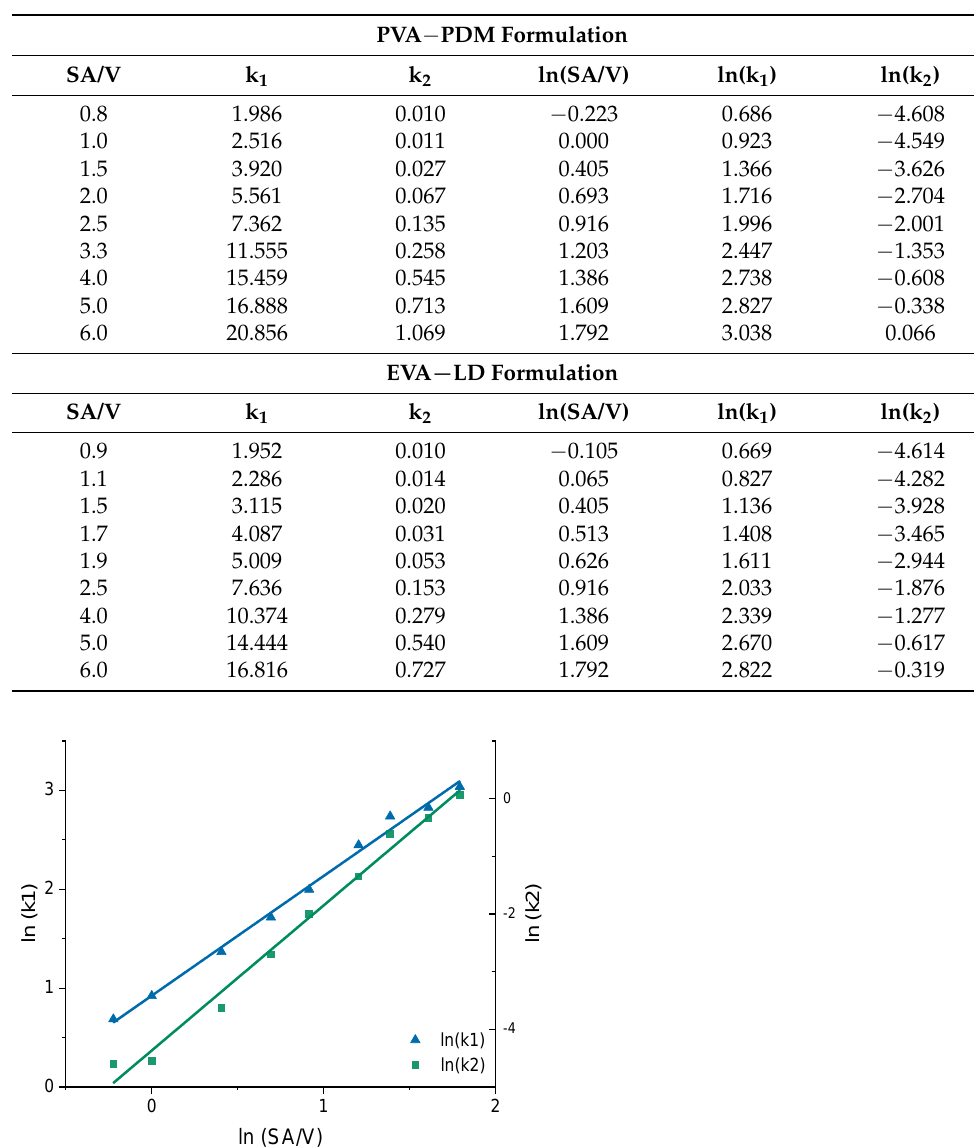
Figure 6. Experimental release data points (black cuboids) and predicted release curve (red line) calculated with Peppas Sahlin (PVA-PDM formulation ( a ); EVA-LD formulation ( b )) and Weibull function (PVA-PZQ formulation ( c )). Table 8. Calculated constants for the SA/V ratios of both BCS I formulations.